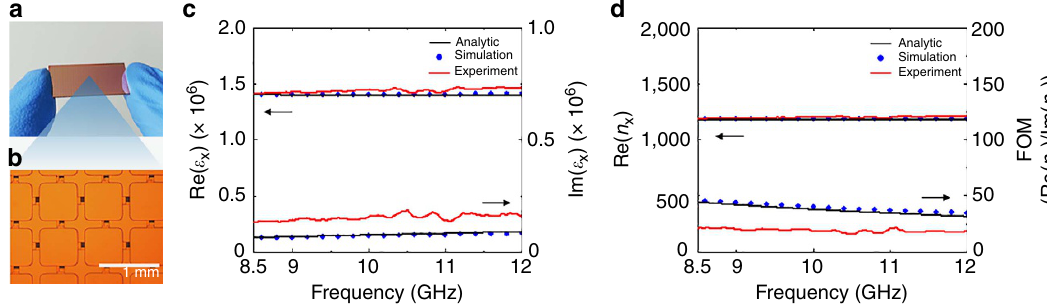
Figure 2 | Effective material parameters of the mesoscopic crystal. ( a ) A macroscopic image of the fabricated mesoscopic crystal. ( b ) Top view of the crystal in an optical microscope. The structural dimensions and the materials are same as in Fig. 1c, but here it is a uniaxial crystal (Methods). ( c ) Retrieved dielectric constants, e x , of the mesoscopic crystal for X-band frequency range. The analytic model, simulations, and experimental data show excellent agreement for Re[ e x ]. ( d ) Retrieved effective refractive index and the figure of merit (FOM, Re[ n x ]/Im[ n x ]) of the mesoscopic crystal. The effective refractive index is constantly larger than 1000, and the experimentally measured FOM is 4 15 for the X-band frequency